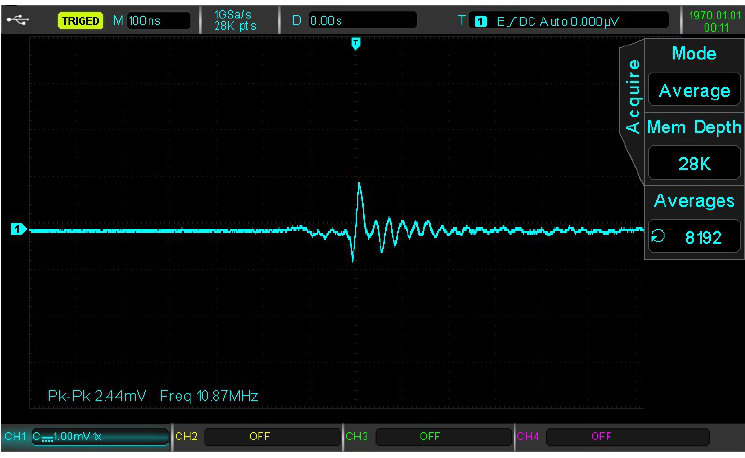
Figure 7. Enlarged view on one PD